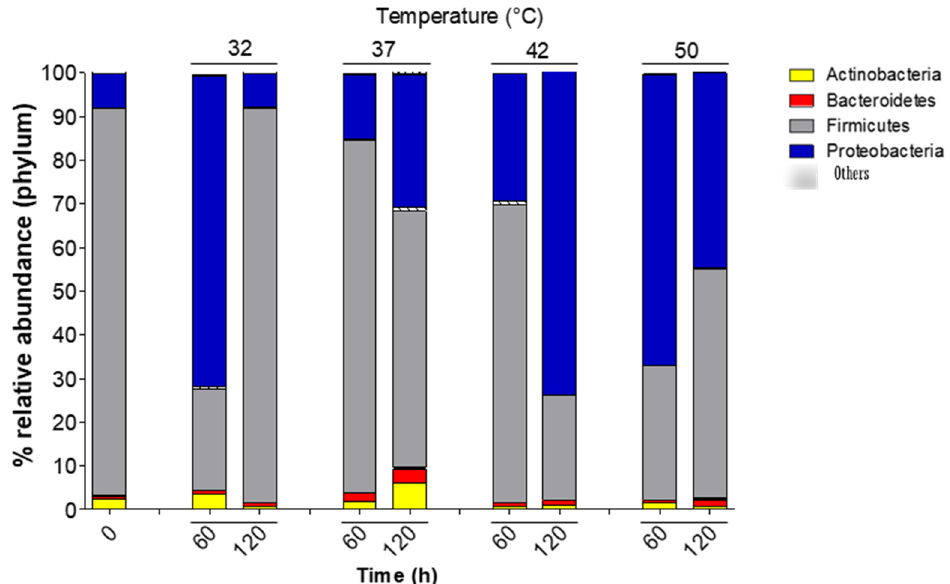
Figure 1. Average abundance (%) of bacterial communities at phylum level found in fermented whey after 60 and 120 h at different temperatures. Others include the phyla Planctomycetes , Spirochaetes , Tenericutes , Caldiserica , Thermotage , Chlamydiae , Cloroflexi , Candidatus Saccharibacteria , and Deinococcus-thermus.